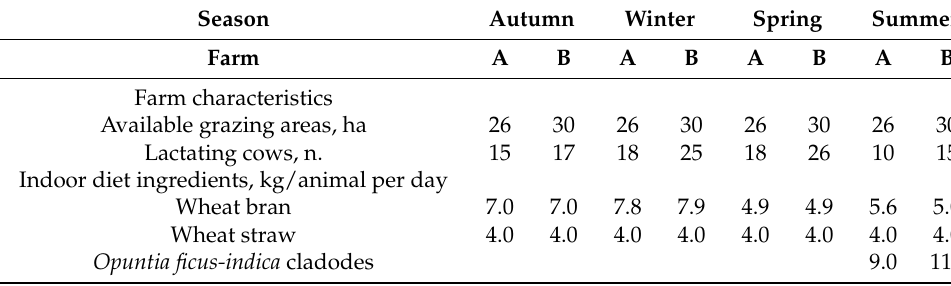
Table 1. Farm characteristics and diet